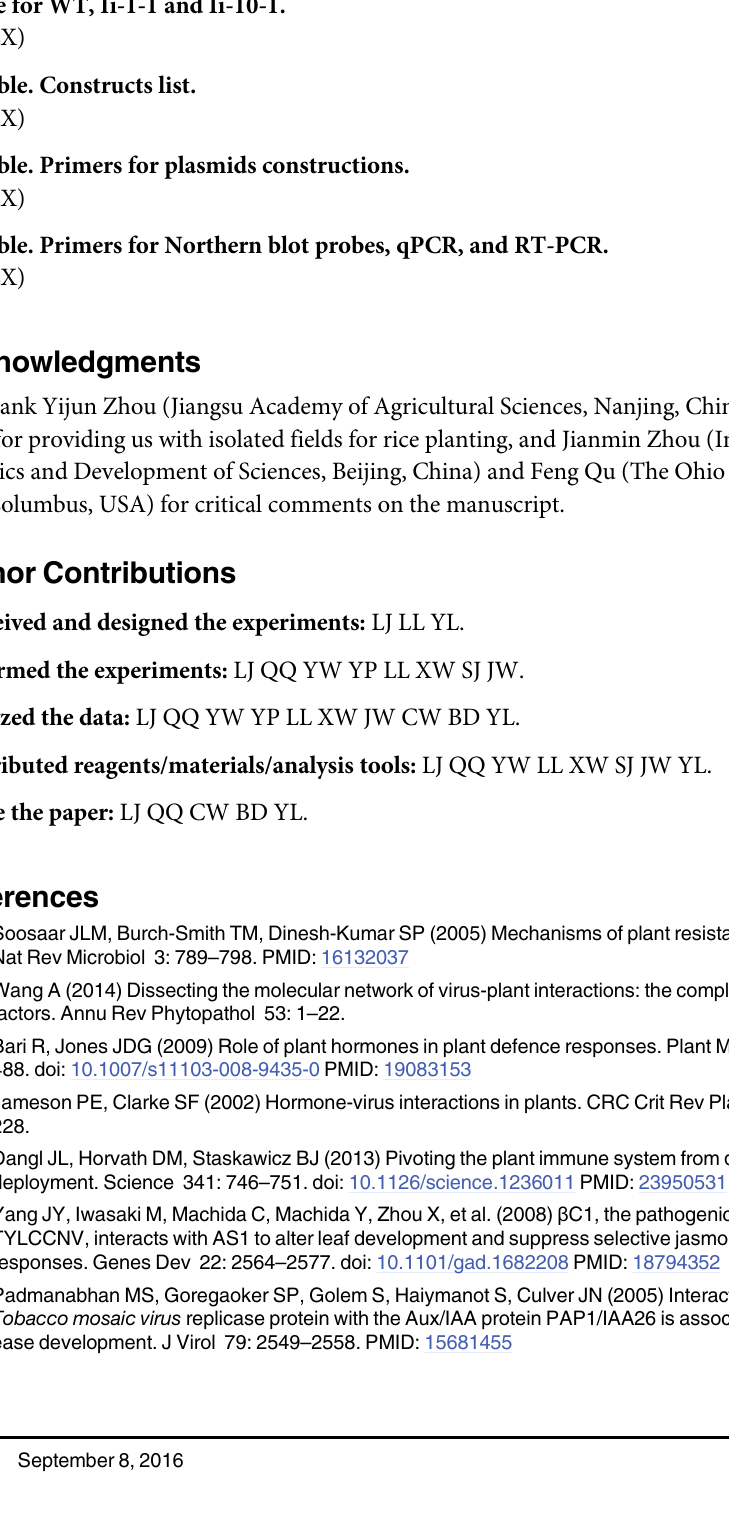
S1 Table. Non-preference test for rice varieties and transgenic lines used in this study. S2 Table. Record of the number of rice lines showing RDV infection symptoms at time course for WT, L12, L20, M7 and M9. S3 Table. Record of the number of rice lines showing RDV infection symptoms at time course for WT, Ii-1-1 and Ii-10-1. S4 Table. Constructs list. S5 Table. Primers for plasmids constructions. S6 Table. Primers for Northern blot probes, qPCR, and